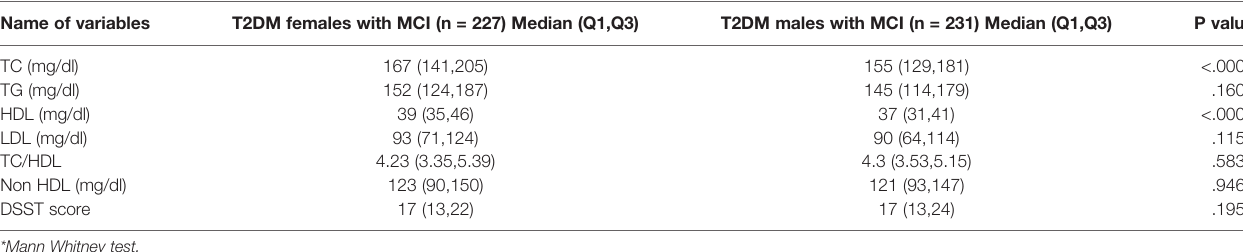
TABLE 4 | Comparison of lipid pro fi le parameters and DSST score in T2DM females and males with MCI.